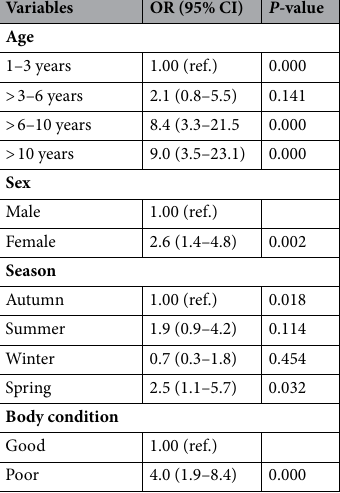
Table 2. Multivariable logistic regression analysis of risk factors associated with T. evansi infection in dromedary camels. OR odds ratio, CI confidence